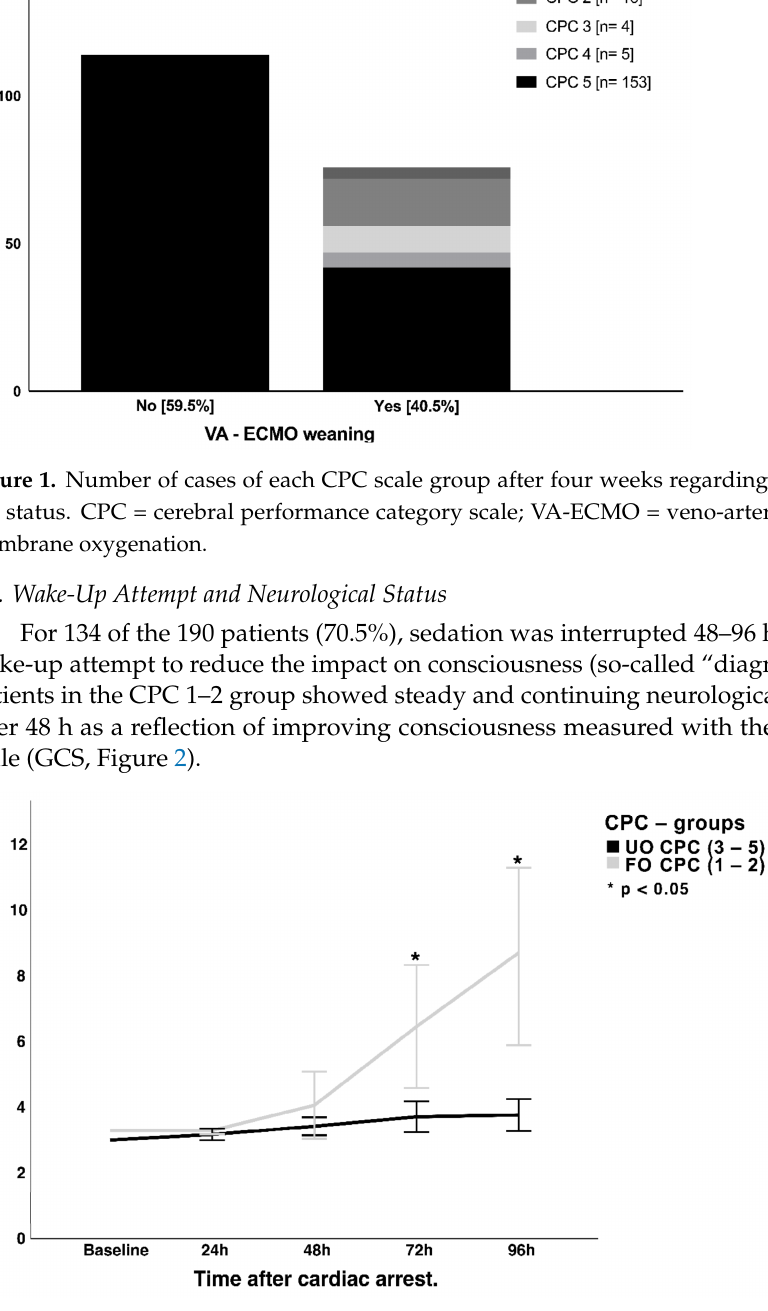
Figure 2. Mean GCS levels of the two CPC groups during a wake-up attempt regarding the first 96 h after VA-ECMO initiation. GCS = Glasgow coma scale; CPC = cerebral performance category scale; UO = unfavorable outcome (CPC 3–5); FU = favorable outcome (CPC 1–2); CI = confidence